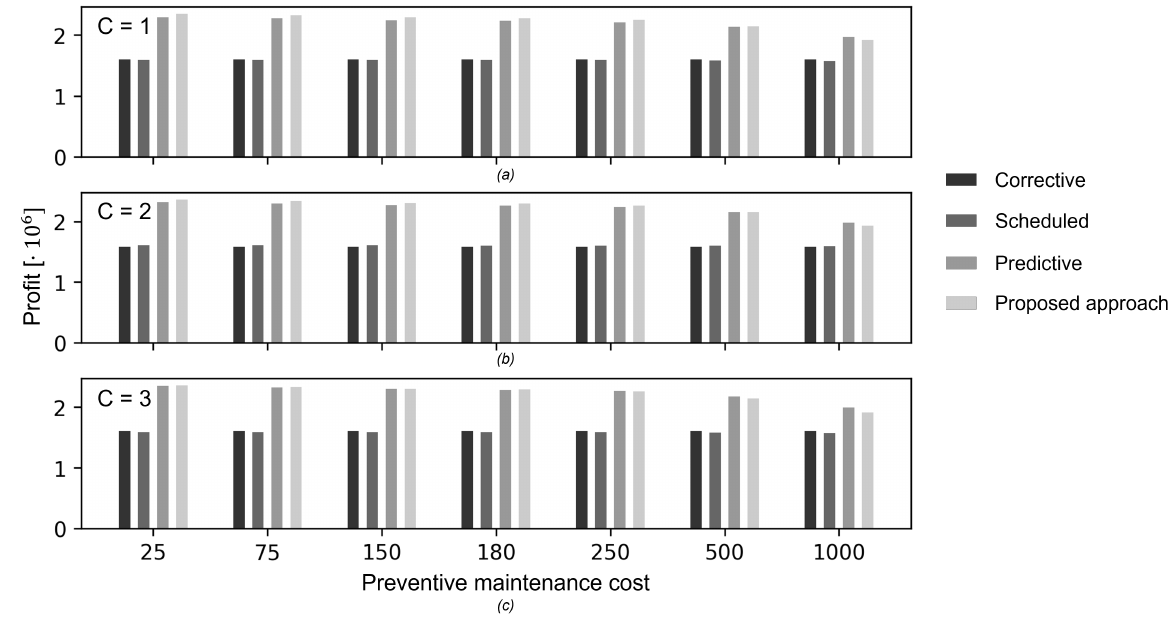
Figure 10. Performance of the considered policies in terms of average profit as a function of preventive maintenance cost in the test episodes with C = 1 ( a ), C = 2 ( b ), and C = 3 ( c ), without